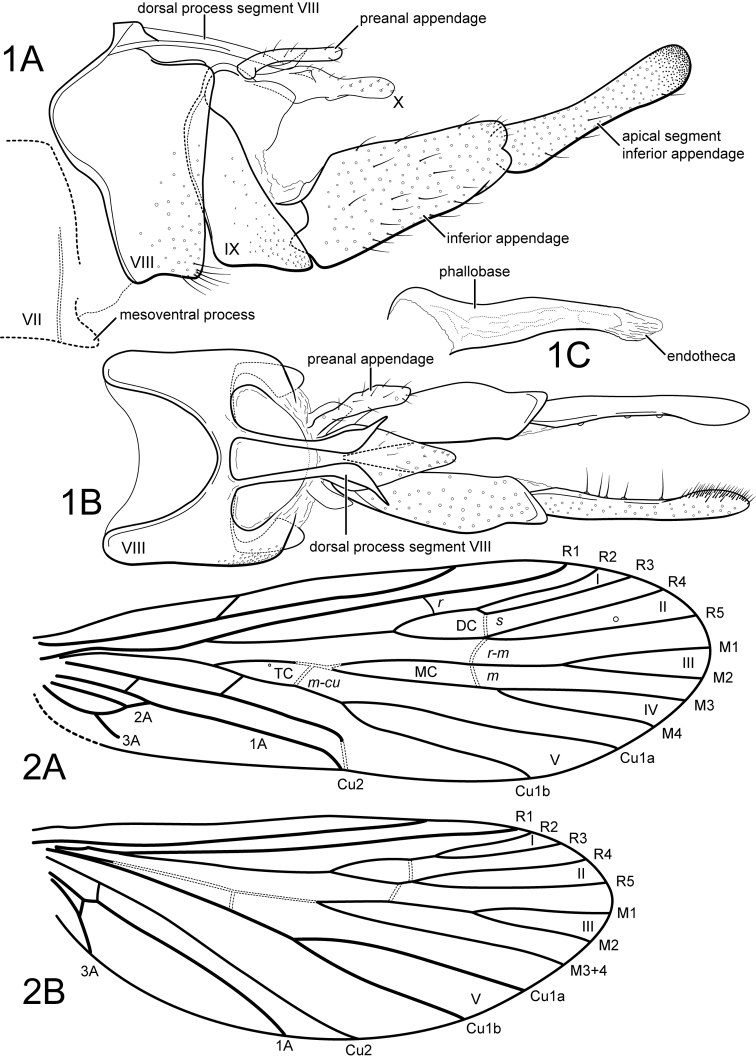
1Aymaradellaboliviana gen. n., sp. n. Male genitalia A segments VII-X, lateral B segments VIII-X, dorsal C phallus, lateral. 2Aymaradellaboliviana, gen. n., sp. n. Male wings A forewing B hind wing.